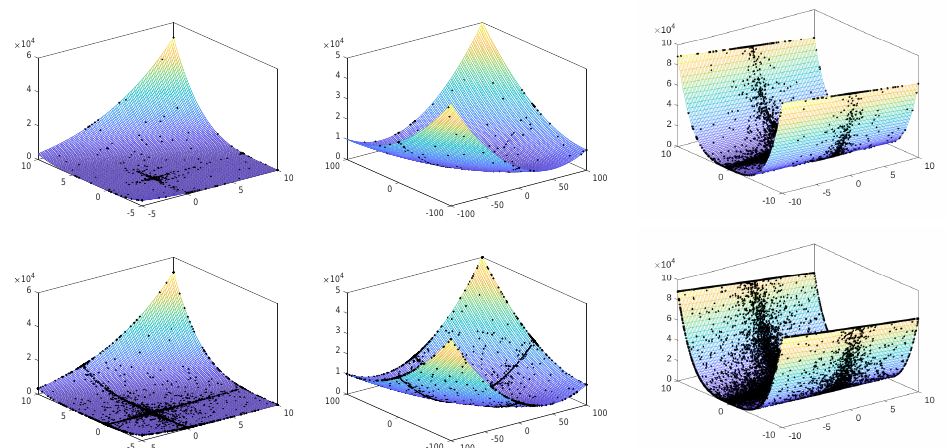
Figure 6. Obtained solutions in the search space of functions f 9 , f 10 , and f 12 ; by the ESCA algorithm ( first row ); and the SCA algorithm ( second row ).